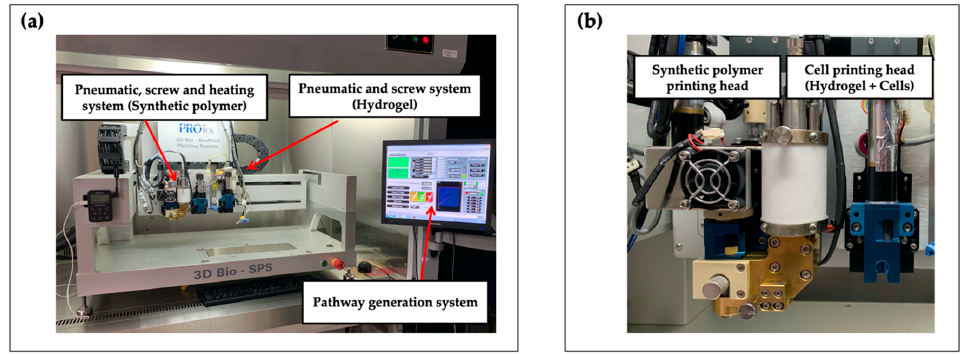
Figure 1. Front view of ( a ) the 3D bioprinting system and of ( b ) its printing heads.